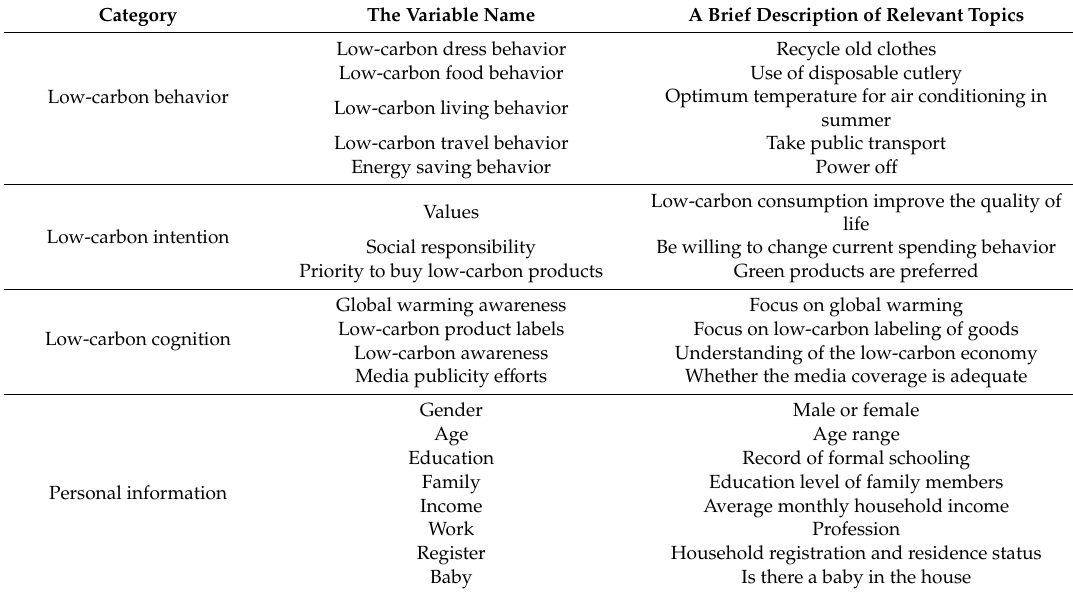
Table 1. Questionnaire